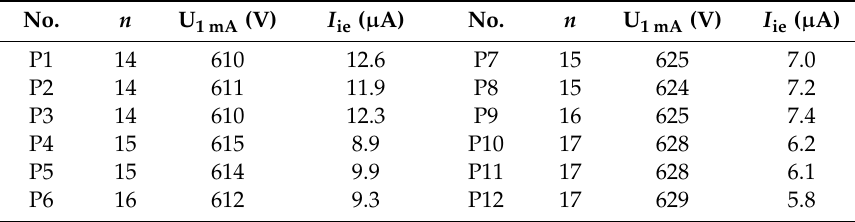
Table 3. The electrical parameters after impulse at different pulse intervals.